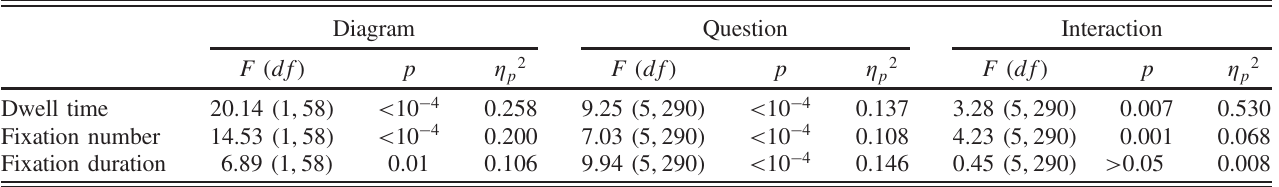
TABLE I. Results of two-way ANOVAs conducted on dwell time, fixation number, and fixation duration for the AOI question with